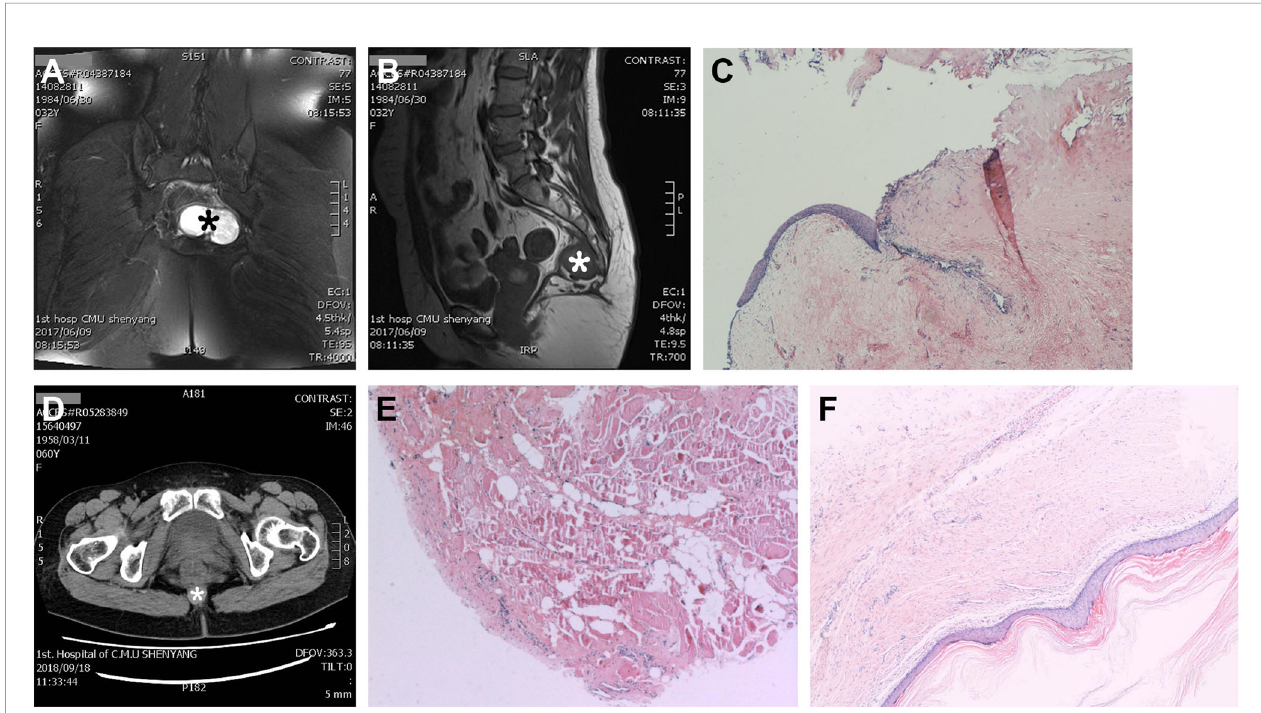
FIGURE 3 | Representative cases of the use of diagnostic imaging and pathology. MRI pelvis with axial view (A) showing a 6.2 cm × 4.4 cm × 4.1 cm tumor (*), and sagittal view (B) showing the relationship between tumor (*) and the walls of the presacral space. (C) Biopsy showing that the tumor contains variety of tissues and surrounded by a cystic wall, which is consistent with a presacral teratoma (A – C) . (D) CT scan image showing a size 2.0 cm × 2.0 cm round tumor (*) with smooth edge and biopsy (E) con fi rms that it is a benign epidermoid presacral tumor. (F) Patient who was diagnosed with a perianal tumor on digital rectal examination and con fi rmed with biopsy, the Hematoxylin-Eosin stain of the cyst wall and content indicating a presacral